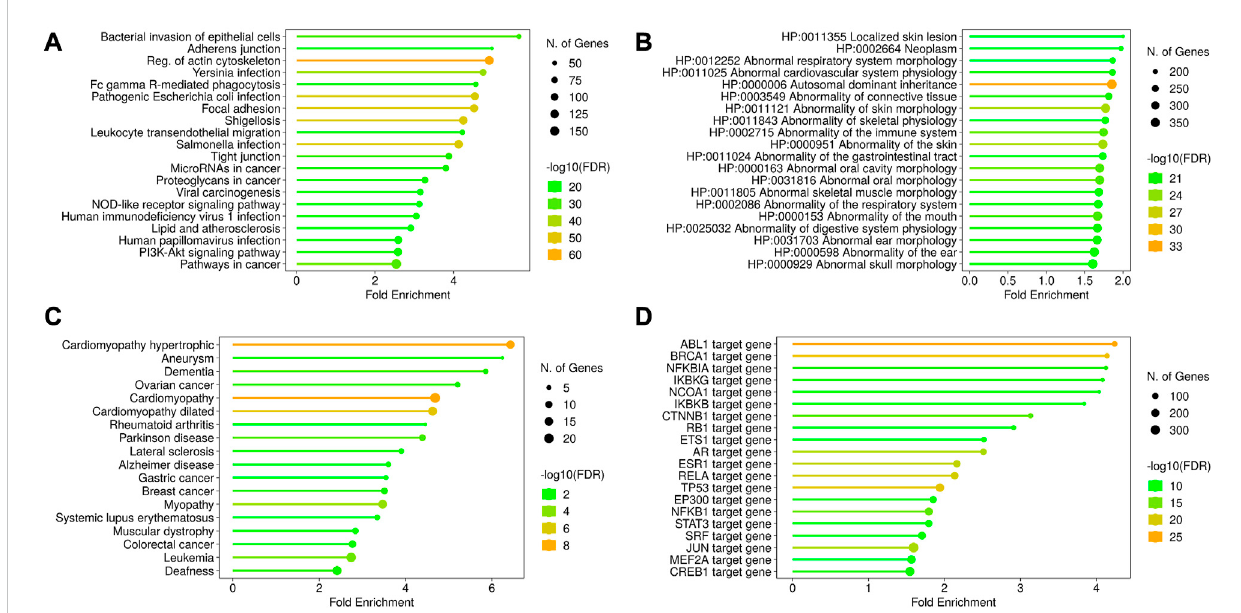
FIGURE 5 Disease ontology and gene regulation details of AAPs. The KEGG pathway enrichment shows the processes related to infection, cell structures, and other disorders in the cell (A) . The disease annotations have been derived from HPO (B) and OMIM (C) using the ShinyGO pipeline. These enriched annotations are for cardiomyopathy, abnormal morphology of tissues, and certain cancers. The transcription factors regulating the AAPs have been shown in (D) . The AAP list shows the enrichment of transcription factors regulating ABL1 and BRCA1 genes, denoting their roles in tumor